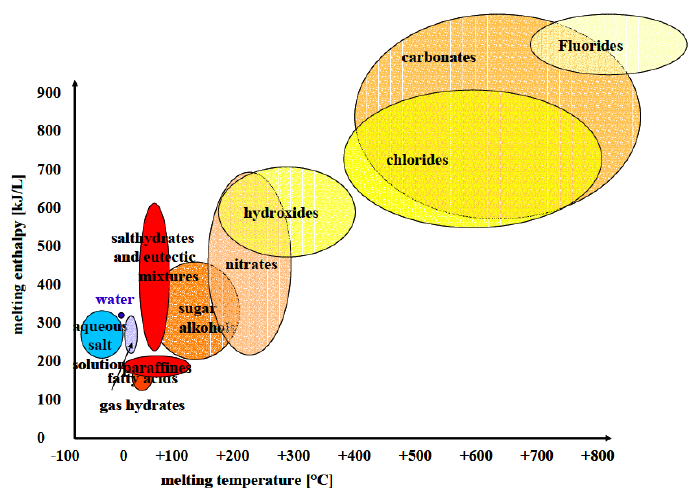
Figure 1. Available phase changing materials and the relation between melting temperature and heat of fusion from these materials.